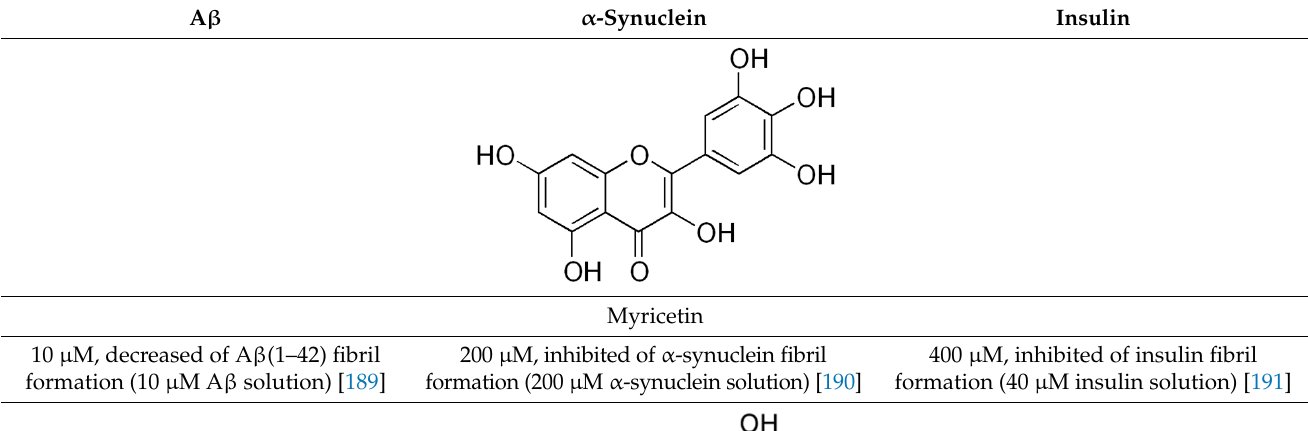
Table 1. Common inhibitors for A β , α -synuclein, and insulin.